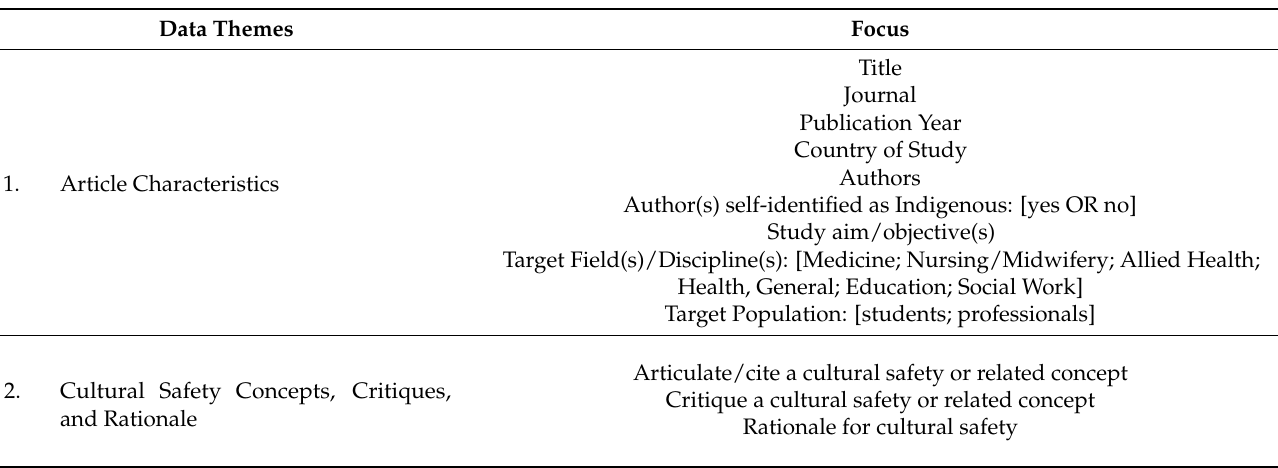
Table A1. Data Themes and